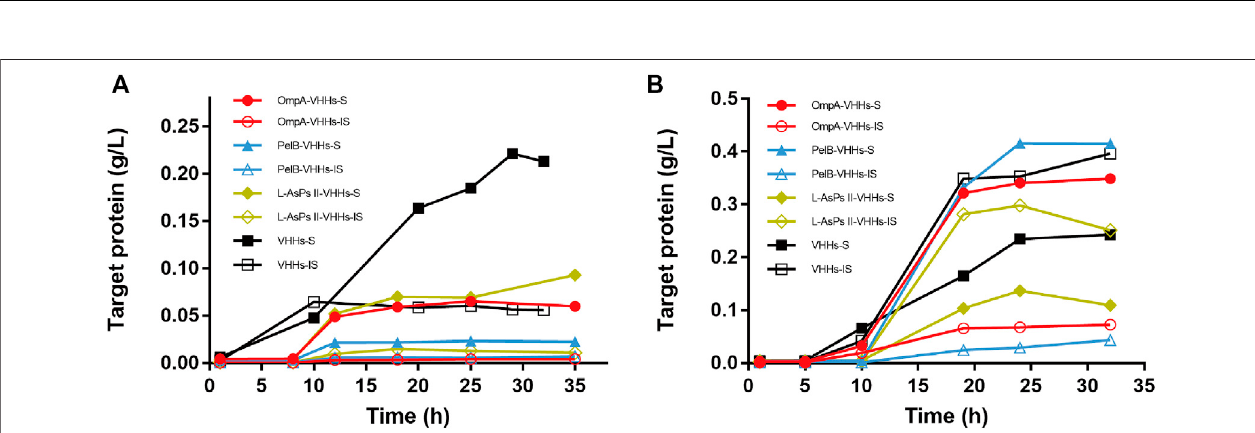
FIGURE 3 | The expression of anti-GFP VHHs with different SPs via auto-induction in E. coli Origami2 (DE3) (A) and BL21 (DE3) (B) . The time-dependent expressionlevelofVHHsalone(black)andVHHswithOmpA(red),PelB(blue),andL-AsPsII-SP(yellow).S,solublefraction;IS,insolublefraction.ConcentrationofIPTG: 0.02 mM. Induction temperature: 25 ° C. M: Enhanced 3-color Regular Range SMOBIO Protein Marker (PA2511) (10.0 – 180 kDa) purchased from